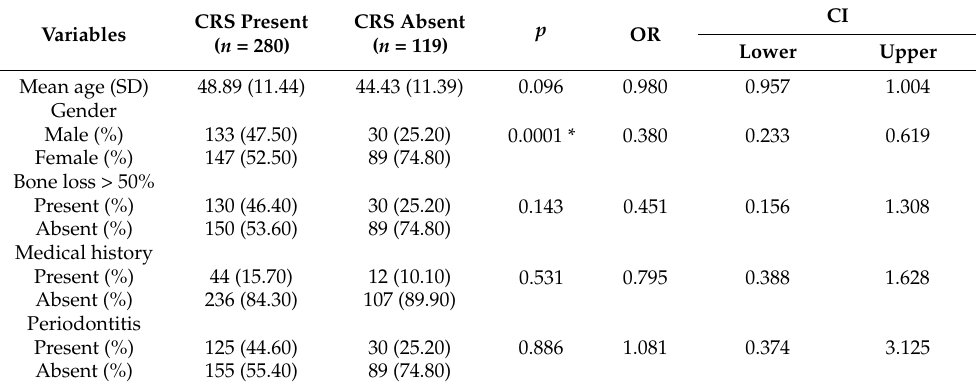
Table 2. Association of CRS and clinical variables.